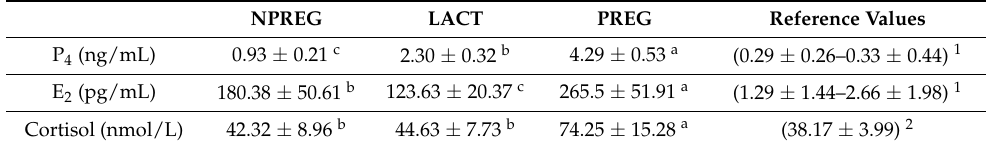
Table 2. Mean values (M ± SD) of P 4 , E 2 and cortisol in non-pregnant non-lactating ( n = 14), non-pregnant lactating ( n = 8) and pregnant ( n = 38) she-camels.